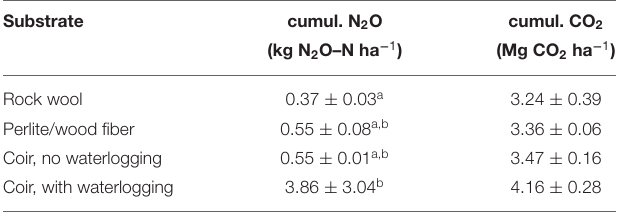
TABLE 5 | Cumulative N 2 O emissions (cumul. N 2 O) and cumulative CO 2 emissions (cumul. CO 2 ) from the root zones of tomato plants grown on rock wool, perlite/wood fiber and coir, with and without waterlogging during the first sampling time